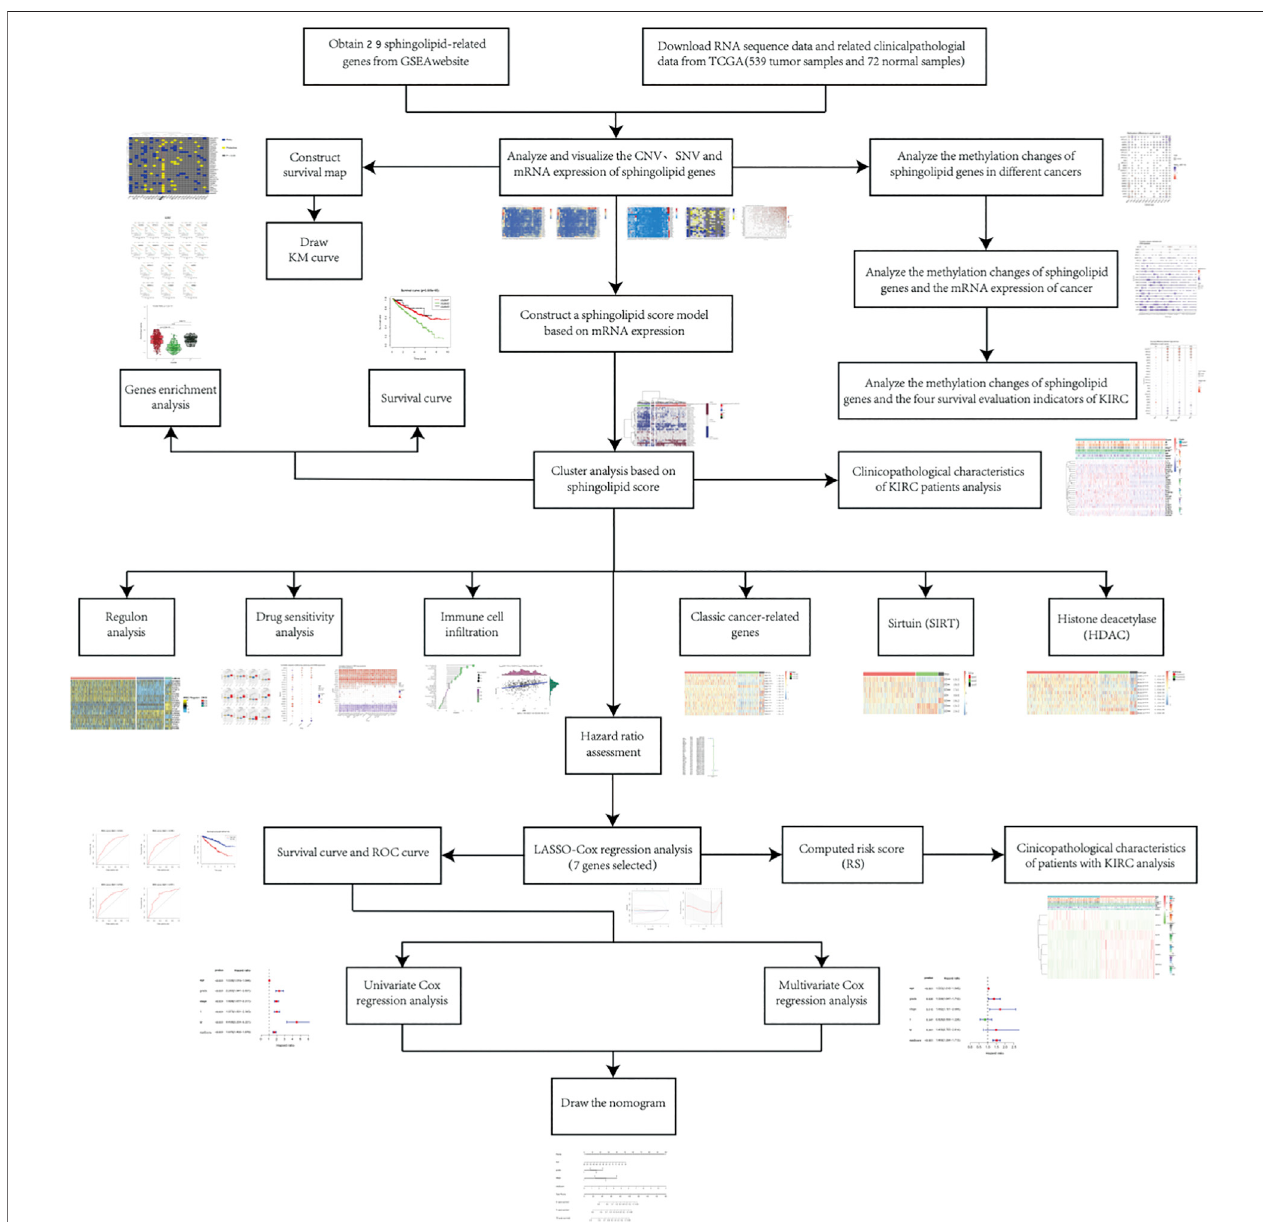
FIGURE 1 | The fl owchart illustrates the research